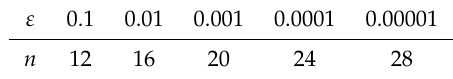
Table 10. Number n of iterations needed by the a posteriori estimate if started with ( 10,50 )